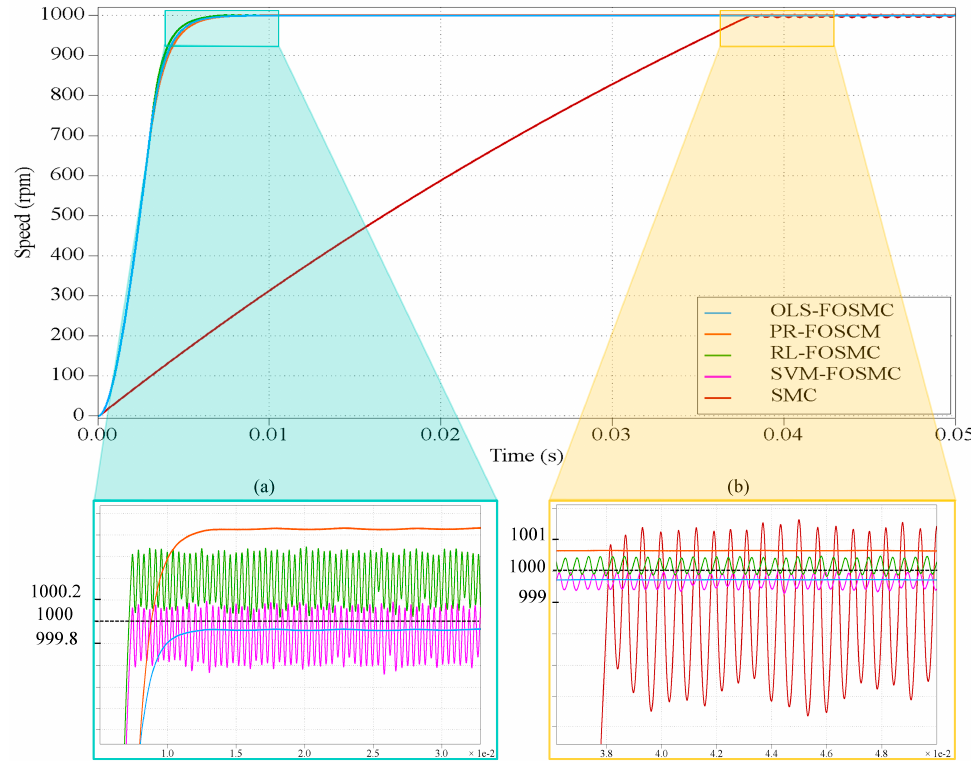
Figure 6. Speed responses of PMSM system under the proposed controllers based on ML and SMC.